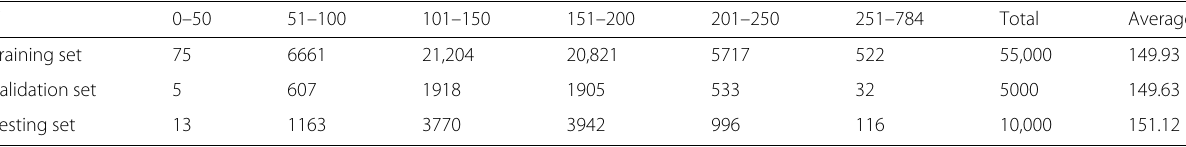
Table 1 The distribution of non-zero entries in the MNIST